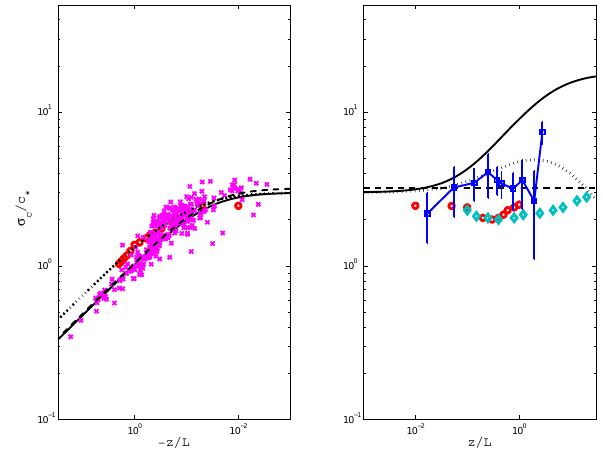
Fig. 2. Dimensionless scalar standard deviation versus stability, z/L : left panel, unstable conditions ( z/L < 0) and right panel, stable con- ditions ( z/L > 0). Lines are mathematical representations: solid – Blomquist et al. (2010, 26a, b); dashed – Andreas et al. (1998, Eq. 5.9a, b, C = 3 . 2), and dotted – Eq. (21) with the COARE3.0 gra- dient function and Eq. (20). The magenta x’s are hourly data from Stratus07; solid circles – digitized from BD90 Fig. 1; Diamonds – data from SHEBA; and squares – data from